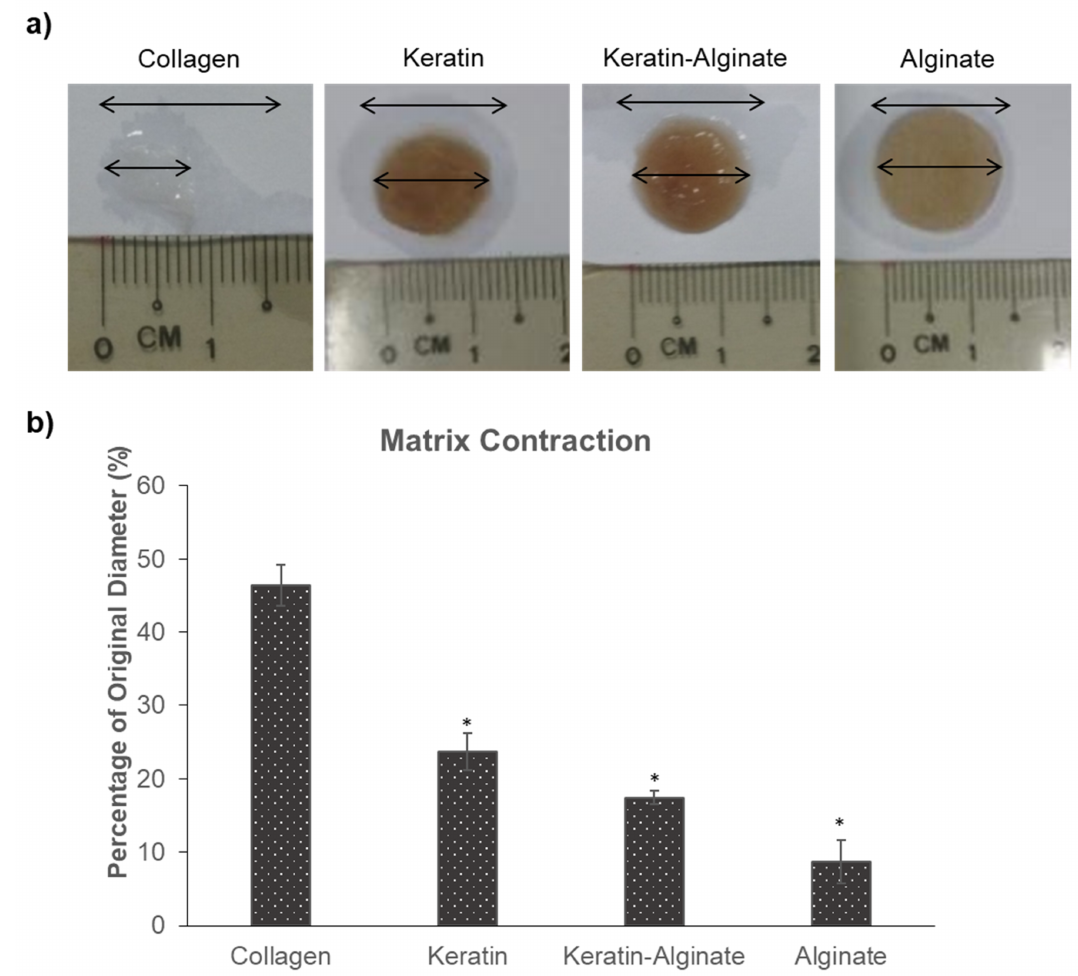
Figure 4. Matrix contraction after 14 days of HDF culture. ( a ) Photographs of matrices after 14 days of culture; Top arrows represent original sponge diameter while bottom arrows represent sponge diameter on day 14 of culture. ( b ) Percentage of scaffold contraction after 14 days of culture (mean ± SD, n = 3), * indicates p < 0.05 vs. collagen (ANOVA, Tukey’s